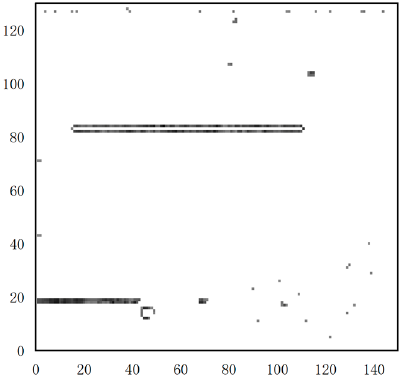
Figure 12. Visualization of the edge detection results.